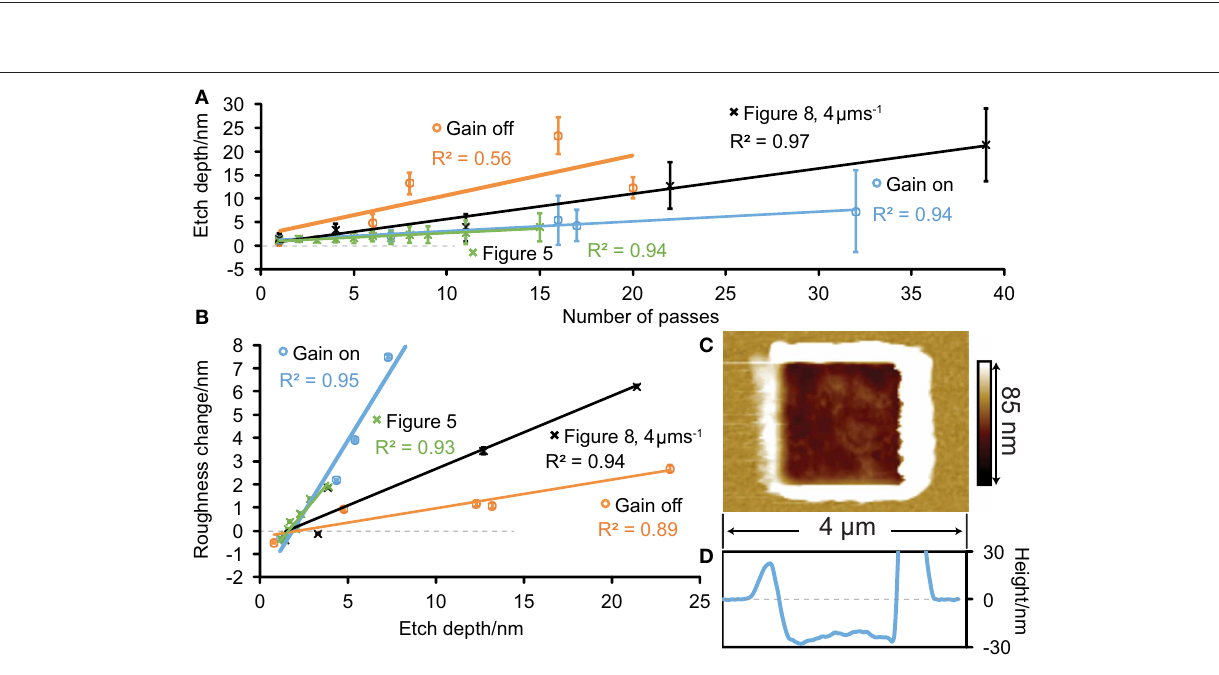
Frontiers in Materials |